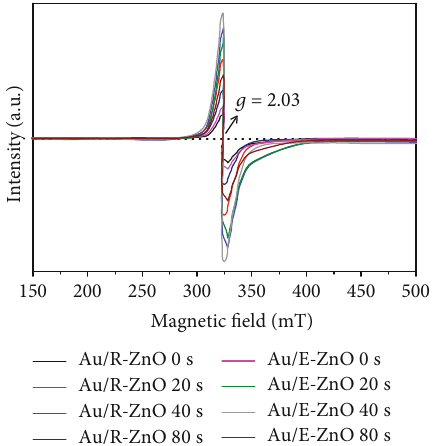
Figure 6: Electron spin resonance (ESR) spectra of Au/R-ZnO and Au/E-ZnO Schottky heterojunction nanocomposites with di ff erent Au NP deposition times (0 s, 20s, 40 s, and 80 s),